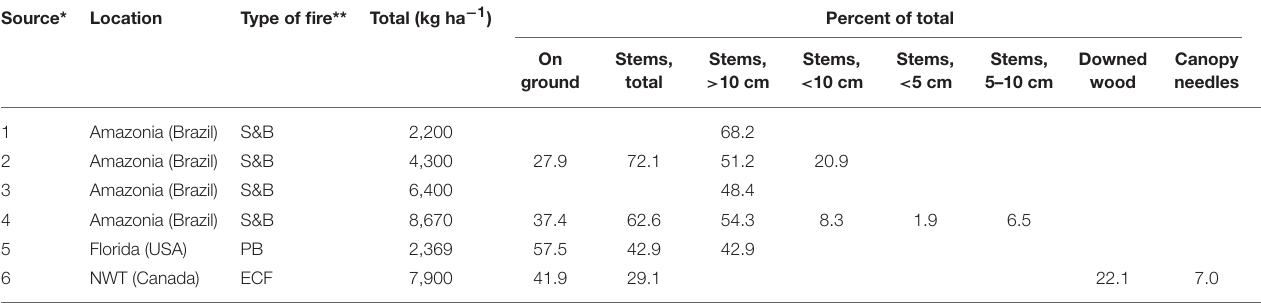
TABLE 5 | Reported distribution of charcoal produced in fires conducted for research purposes. Source*